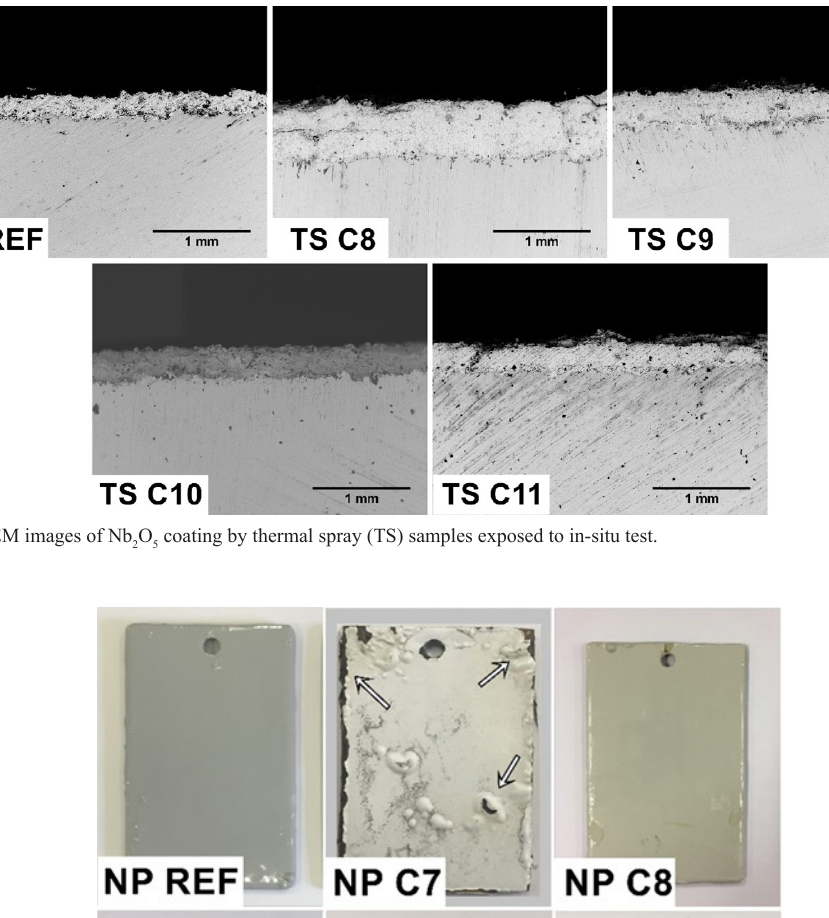
Figure 7. Epoxy-Nb